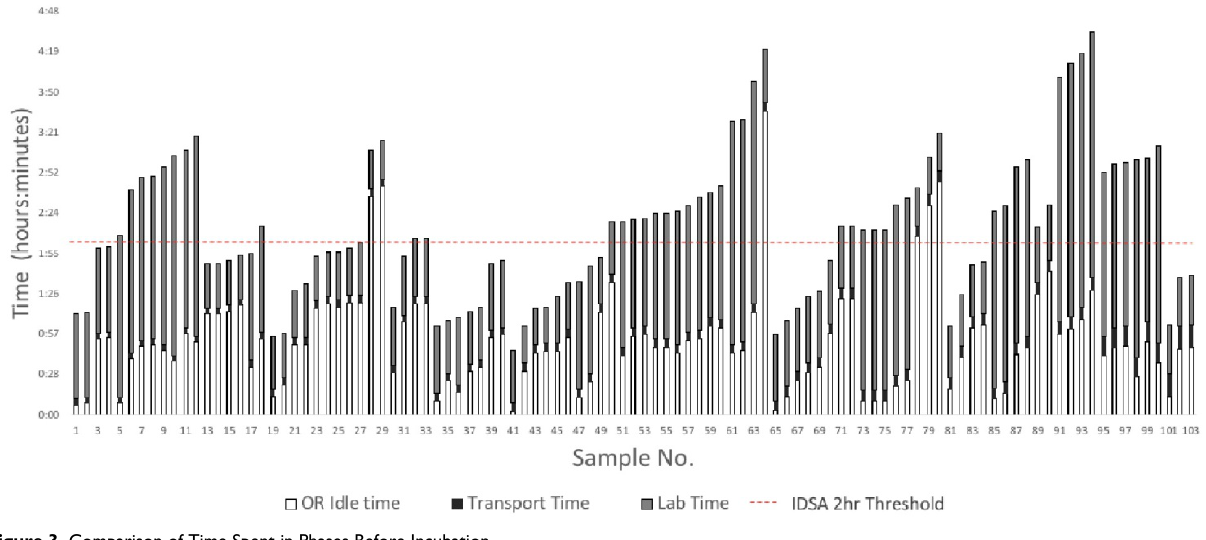
Figure 3. Comparison of Time Spent in Phases Before